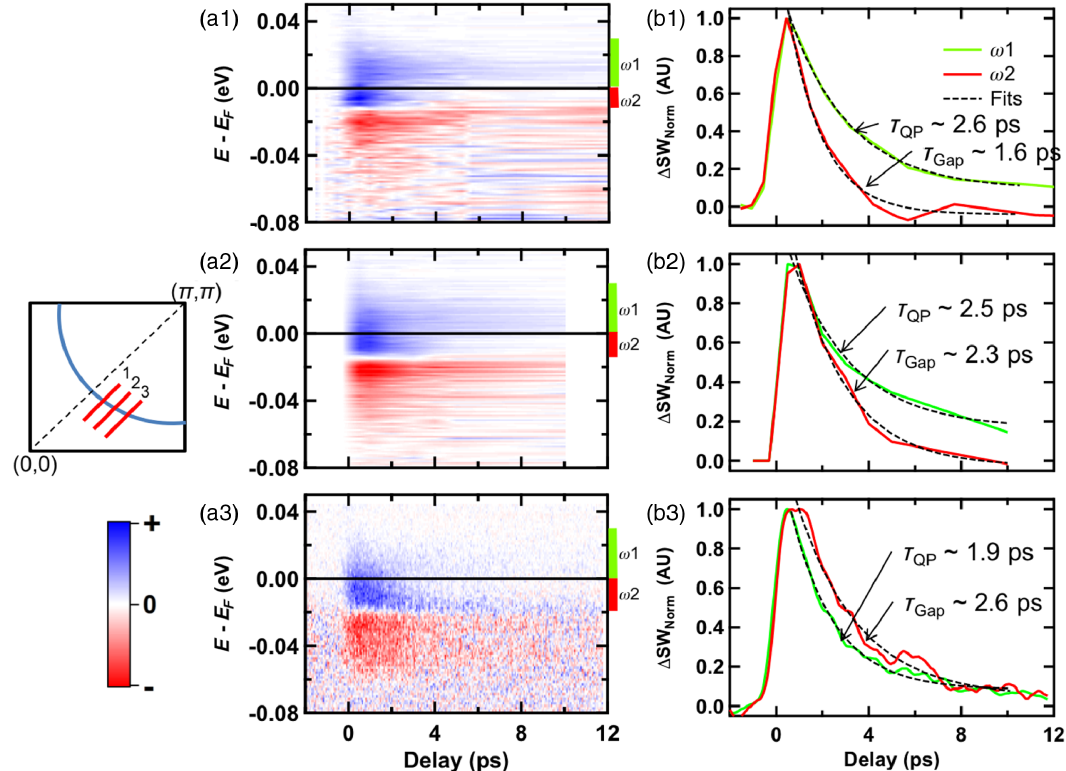
FIG. 5. Off-nodal momentum dependence of Δ SW maps. Panels (a1) – (a3) show Δ SW maps for three different cuts, with k -space locations shown by the inset in panel (a2). Panel (a1) has the same data as Fig. 4(a), reproduced for ease of comparison. Panels (a1) – (a3) have gap sizes of Δ ¼ 12 , 15, and 22 meV, respectively. Panels (b1) – (b3) show the temporal line cuts corresponding to each Δ SW map. The integration windows used to generate the line cuts in panel (b) are shown with red and green bars to the right of each Δ SW map. Panels (b1) – (b3) also show single exponential fits in black dashed lines, with extracted τ ’ s indicated in the